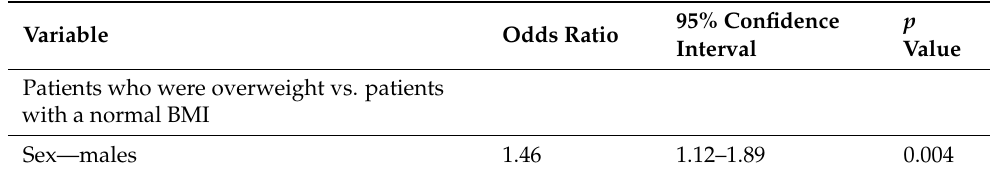
Table 4. Carotid endarterectomies—significant differences between the compared body mass index groups, according to the multivariate logistic regression analysis.